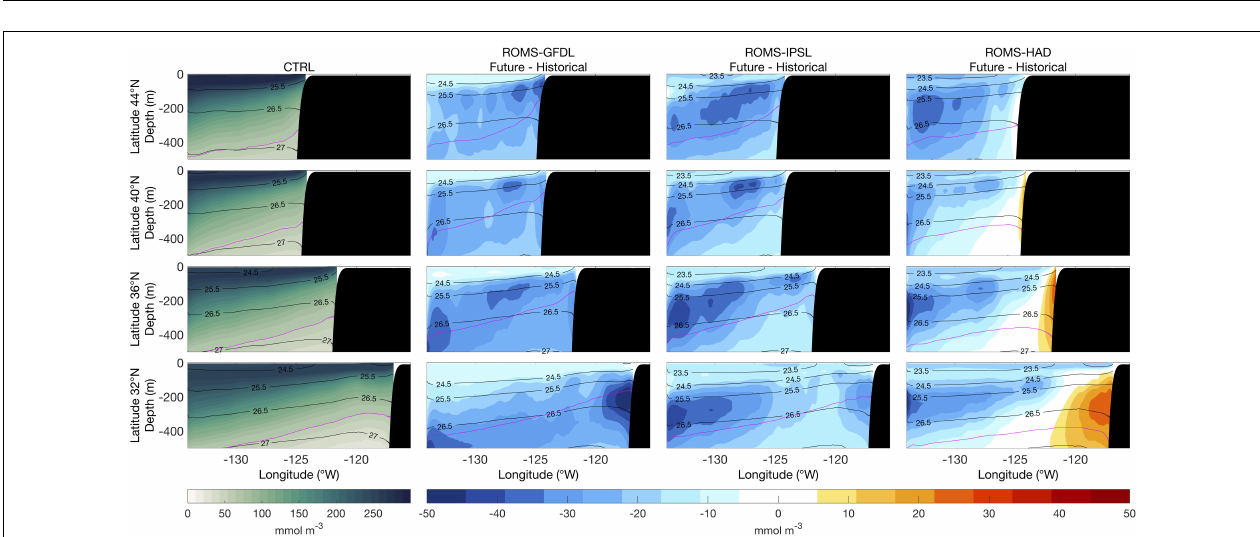
FIGURE 6 | Vertical sections of mean nitrate (1980–2010) from the control run (CTRL, first column) and of future nitrate changes (2070–2100 relative to historical) from the high-resolution downscaled projections: ROMS-GFDL (second column), ROMS-IPSL (third column), and ROMS-HAD (fourth column). Black contours are potential density (kg m − 3 ) relative to sea surface.